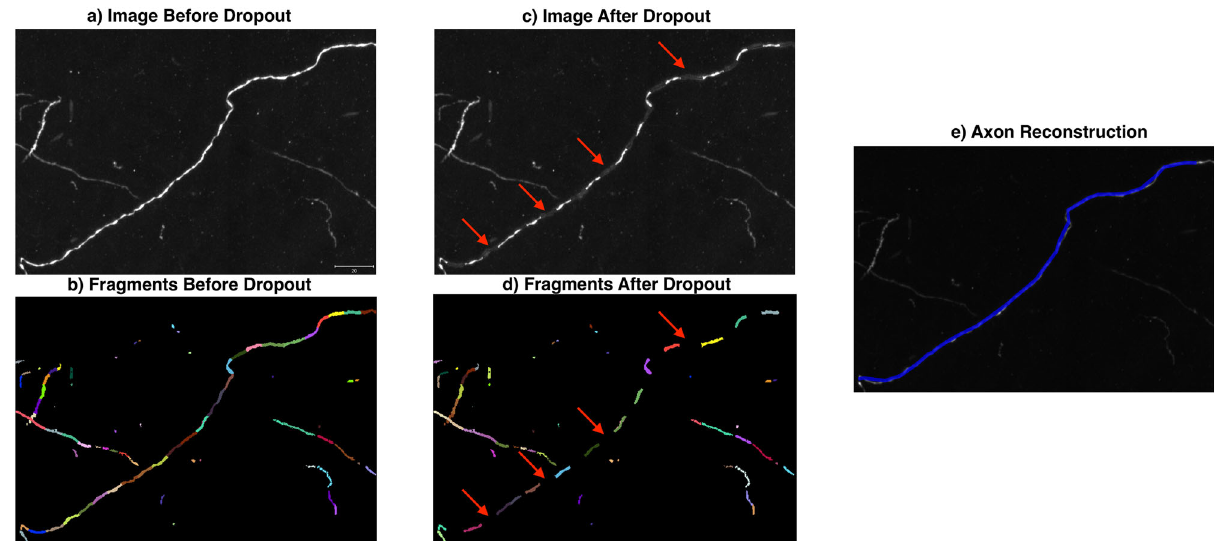
Fig. 5 ViterBrain is robust to image intensity and fragment dropout when axons are relatively isolated. a An image subvolume from the MouseLight project containing an axon. The scale bar represents 20 microns. b The same image, overlaid with the fragments which are depicted in different colors. c The image intensity was censored periodically along an axon path (red arrows). d The fragments associated with the censored regions were removed from the fragment space (red arrows). e Nonetheless, our algorithm was able to jump over the censored regions to reconstruct this axon. All images are